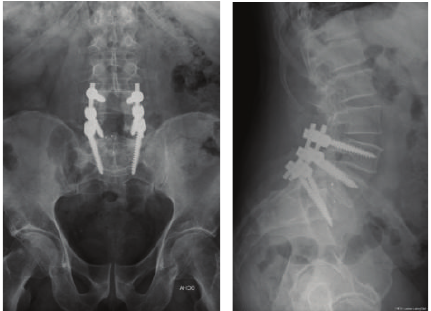
Figure 5: Postoperative X-ray. One-year